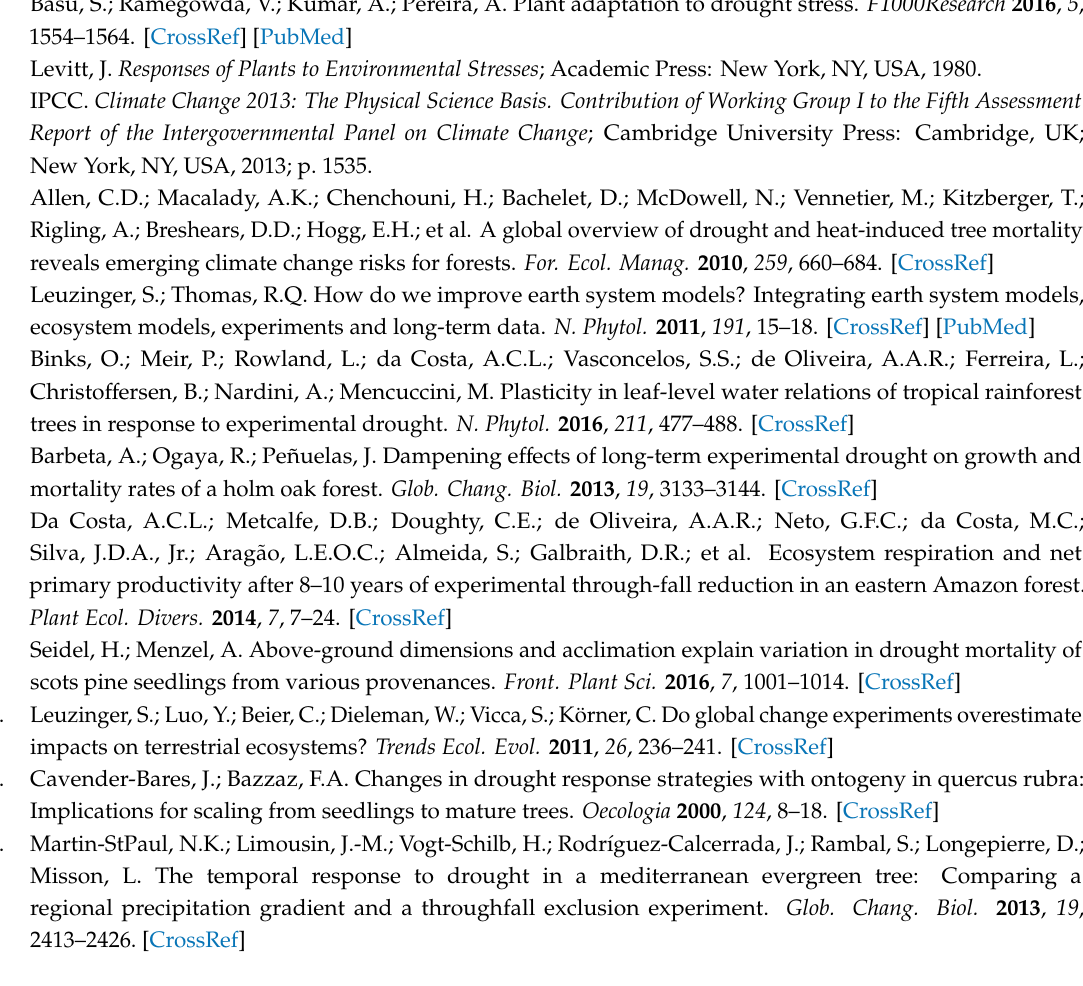
Figure S1: Throughfall reduction setup (a) concept and (b) implemented field setup in the Wombat State forest. Figure S2: Leaf hydraulic vulnerability for mature E. obliqua populations. Table S1: ANOVA results for comparison between impact and control treatment. Table S2: E ff ect size (Hedges’ g), replication (N Group 1, N Group 2) and confidence interval (CI) for each water relations